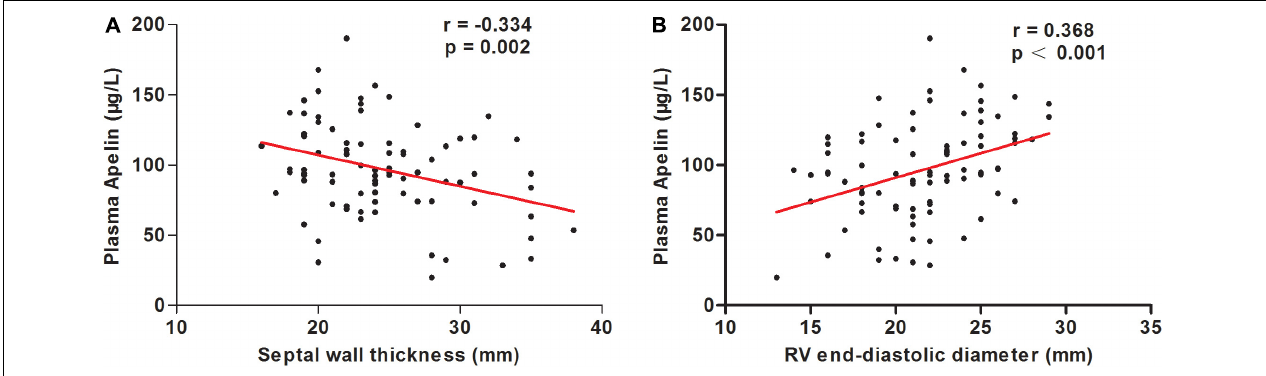
FIGURE 2 | Correlations between plasma apelin levels and septal wall thickness (A) and right ventricular (RV) end-diastolic diameter (B) in patients with obstructive hypertrophic